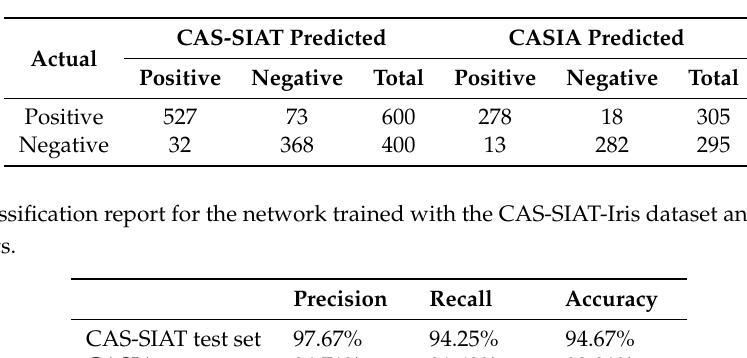
Table 4. Confusion matrix for the network trained with the CASIA-Iris-Interval dataset and tested with both datasets.